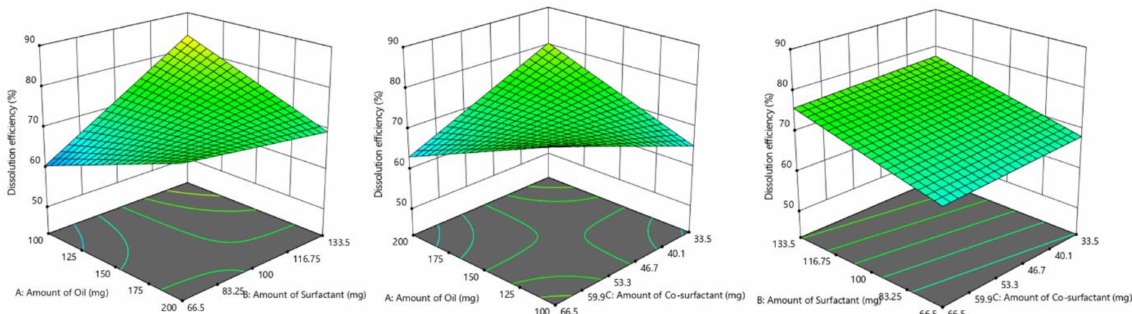
Figure 4. 3D surface plot displaying the influence of formulation factors: glycerol triacetate (oil); Tween 80 (surfactant); and PEG 200 (co-surfactant)] on dissolution efficiency % (Y 1 ). The fitted polynomial equation to dissolution efficiency % (Y 1 ) is: Y 1 = 72.15 − 0.198X 1 + 4.68X 2 − 0.868X 3 − 7.06X 1 X 2 − 7.78X 1 X 3 + 0.00375X 2 X 3 − 1.97X 1 X 2 X